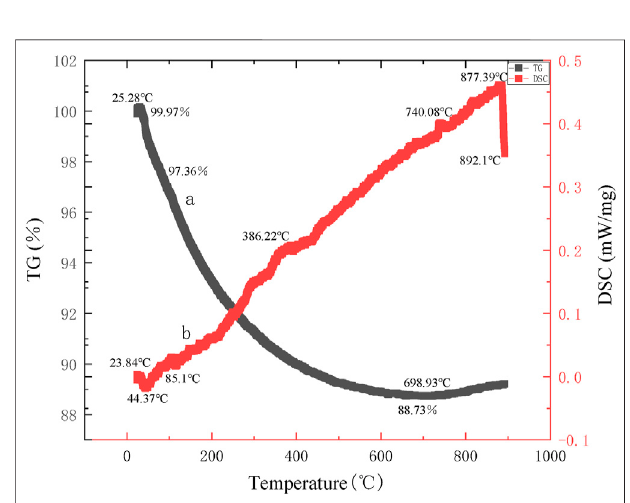
FIGURE8 | The synthesis temperature was70 ° Cand theSi/Al ratio was